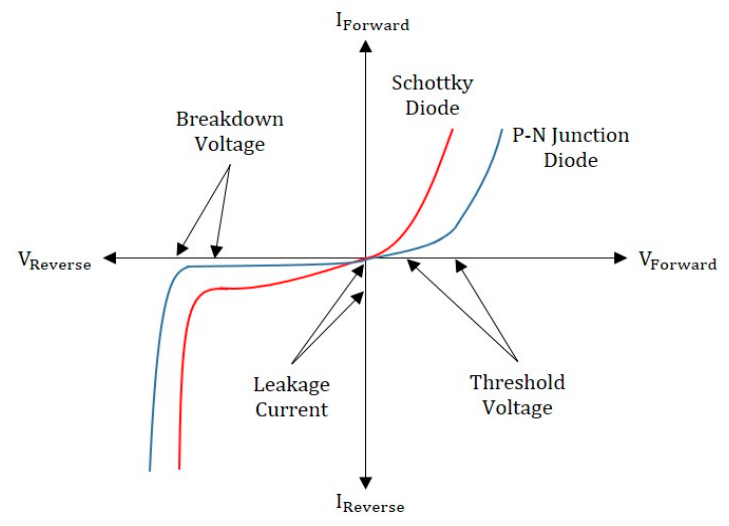
Figure 1. General I–V curves of the Schottky and PN junction diodes.